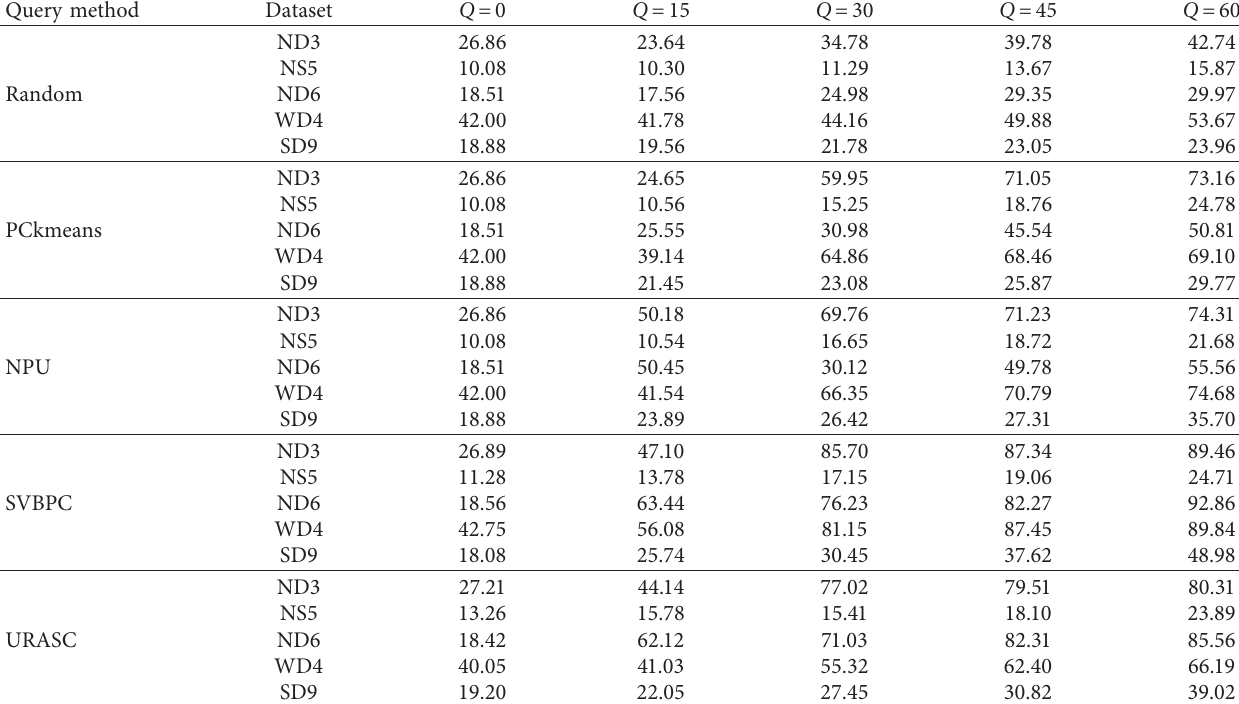
Table 2: NMI details for the proposed